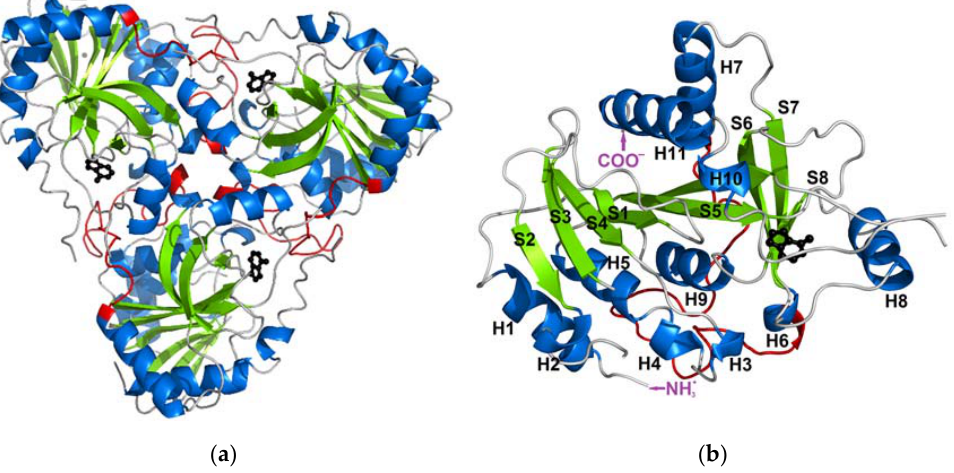
Figure 1. The structure of the trimeric, biologically active, calf purine nucleoside phosphorylase in the complex with one of its substrates, hypoxanthine (PDB ID: 1VFN [13]). Secondary structure elements: alpha helices and beta sheets are colored blue and green, respectively ( a ) The overall structure of the trimeric enzyme. Direct contacts between the monomers forming the trimer are mainly from the long loop (shown in red) between residues 141 and 168 of one monomer, which is the longest loop belting the monomer from one side. ( b ) The structure of one monomer showing the notation of the secondary structure elements.